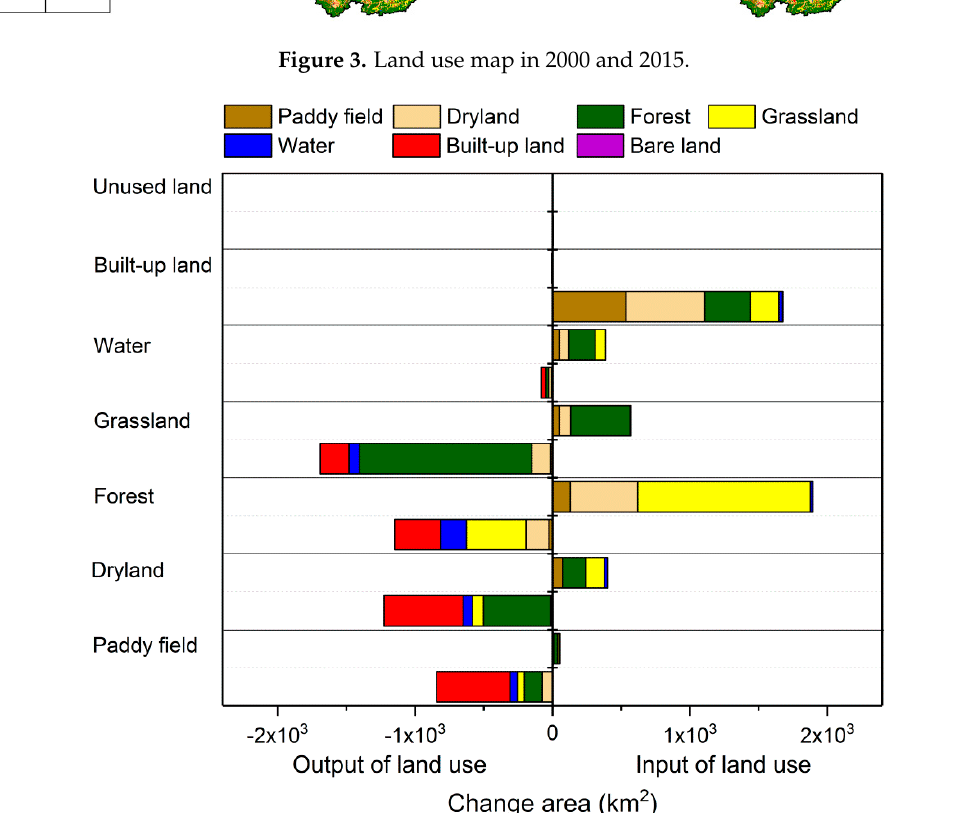
Figure 4. Conversion between multiple land uses from 2000 to 2015.